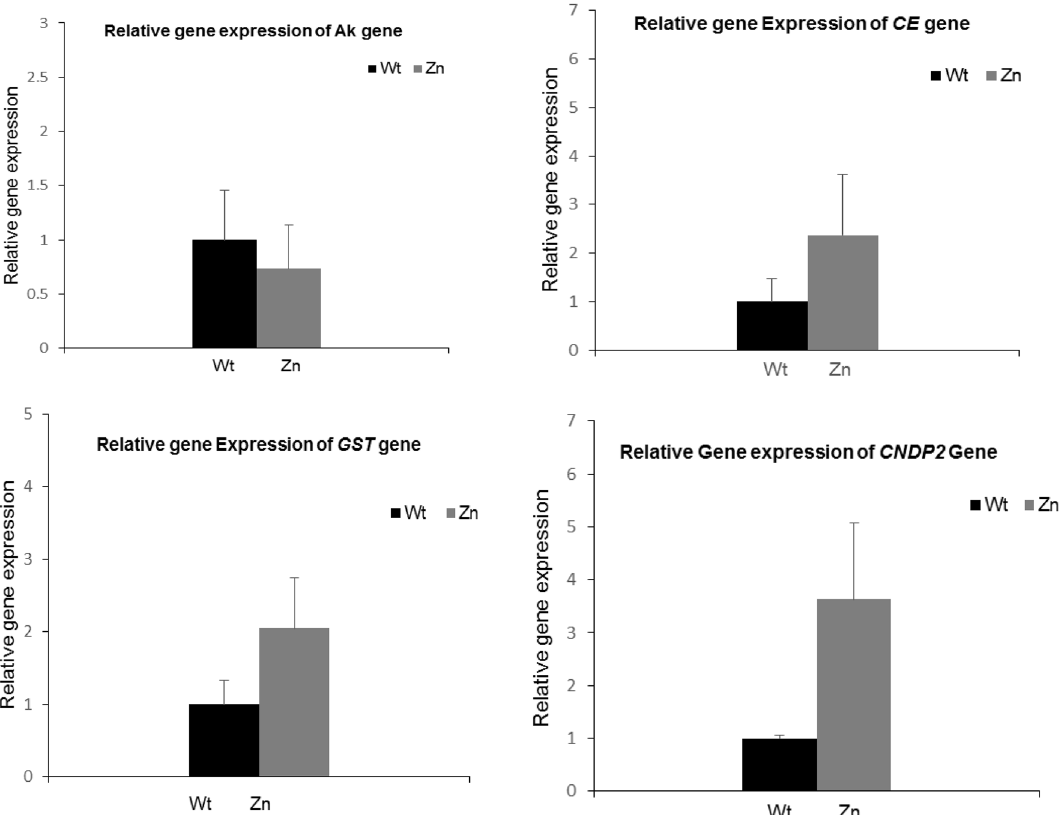
Figure 6. Quantitative RT-PCR of Ak, GST, CNDP2 and CE genes in the 5th instar larvae of B. mori fed on 100 μg/ml ZnO-NPs. For each sample, RNA was extracted, transcribed to C-DNA and normalized to the house keeping gene Tubulin α . Error bar represents +